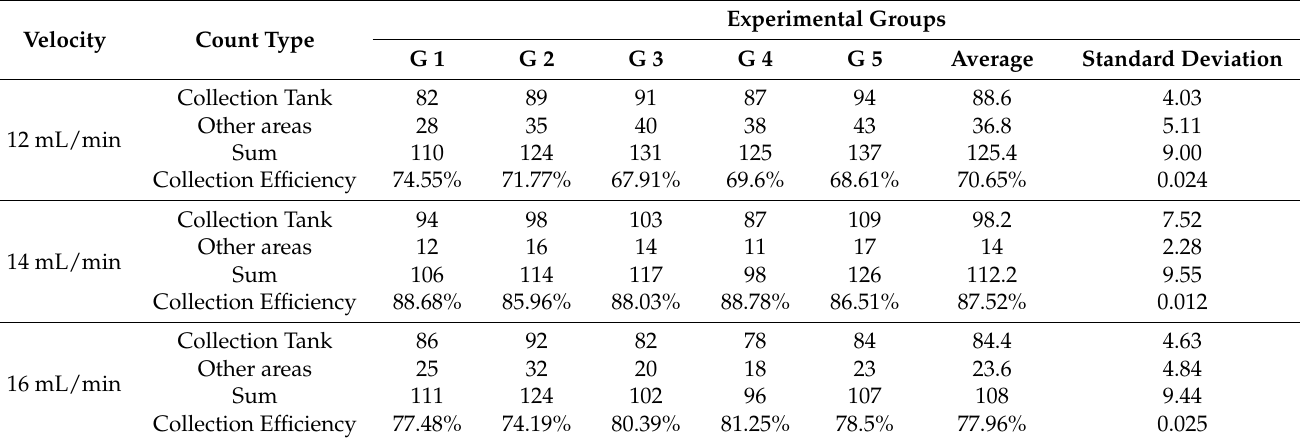
Table 1. Statistics results of spore